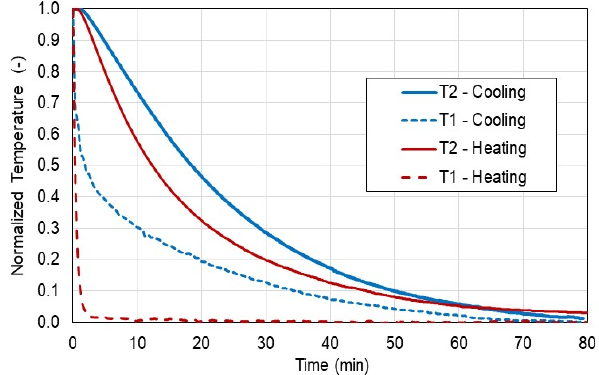
Figure 5. Normalized temperature for heating and cooling tests.